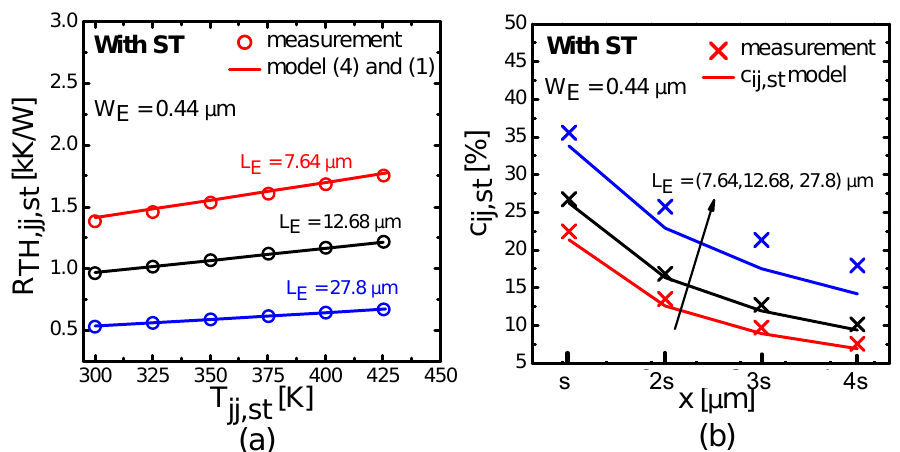
Figure 8. ( a ) T jj , st − dependent R TH , jj , st and ( b ) c ij , st at different sensing fingers: A comparison between the proposed model (lines) and measurements (symbols) [22] for devices with varying L E at a fixed W E . Here finger spacing s = 3.23 µ